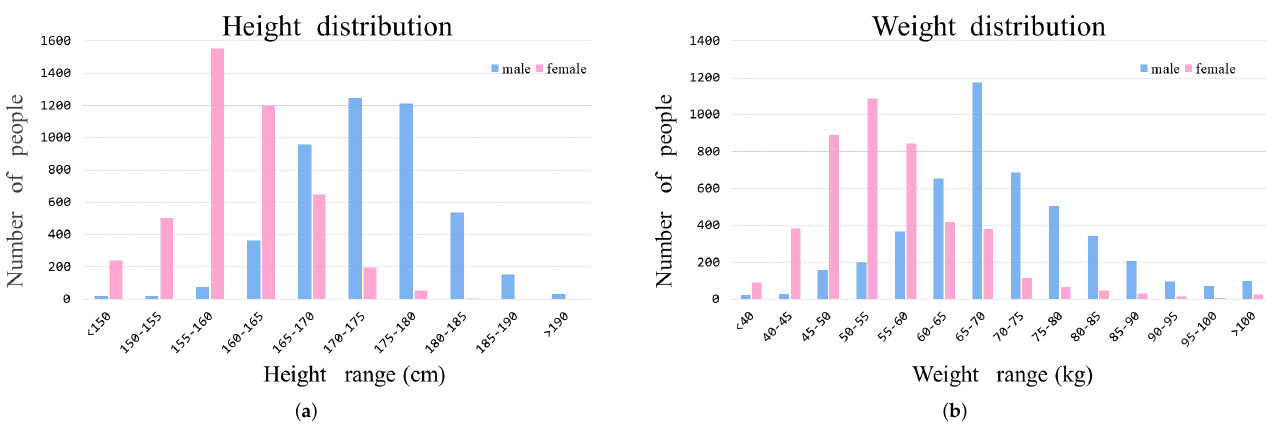
Figure 3. Analysis of the contour keypoint dataset: ( a ) is height distribution and ( b ) is weight